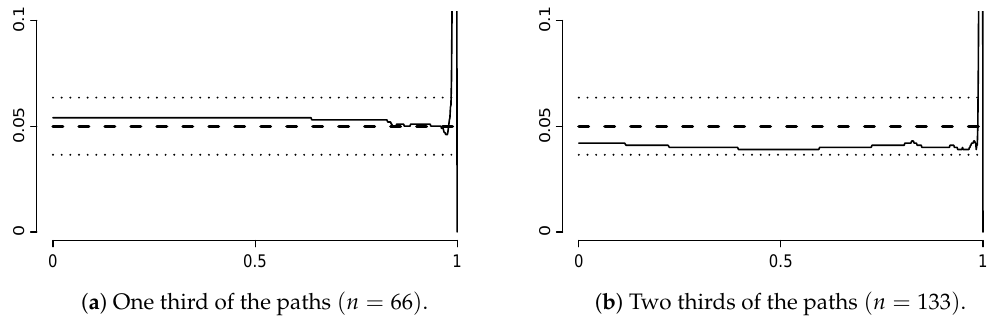
Figure 3. Pointwise proportion of trials, out of M = 1000, in which the true boundary does not belong to the interval delimited by the confidence curves. We use S = 10, X 0 = 10, T = 1, λ = 0, σ = 1, and a significance level α = 0.05, and a number M = 1000 of sample paths. For each path, one third ( a ) or two thirds ( b ) of the observations were used to compute σ and then to estimate the confidence curves by (19). The continuous line represents the proportion of non-inclusions, the dashed line stands for (cid:113) α ( 1 α ) z 0.025 α , and the dotted lines are placed at the values α . The spikes at T = 1 are numerical − M ± ( T ) artifacts due to the null variance of ˜ b (cid:98) σ n